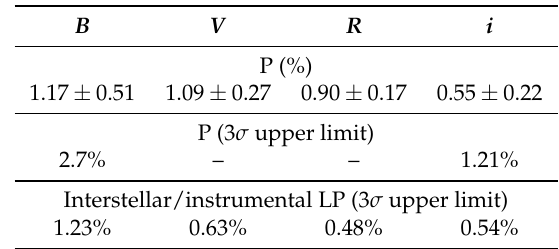
Table 2. Results of the optical polarimetry performed on PSR